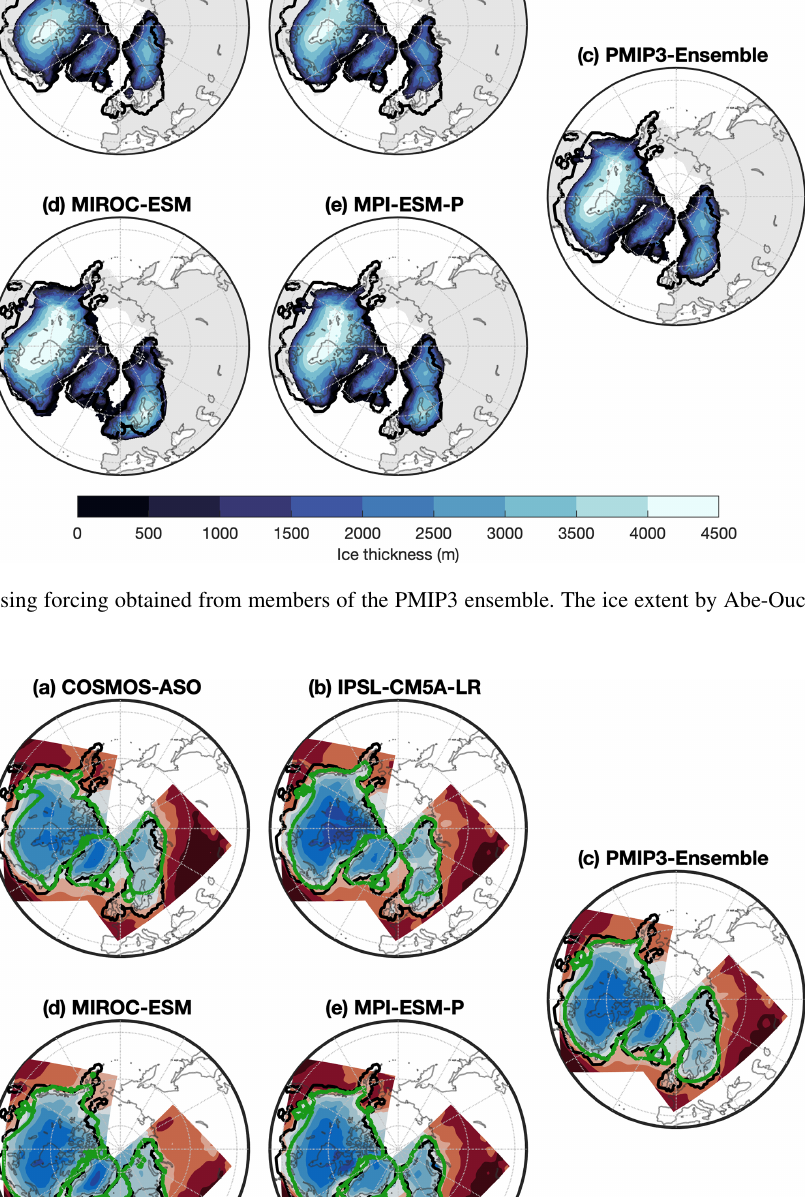
Clim. Past, 19, 399–418, 2023